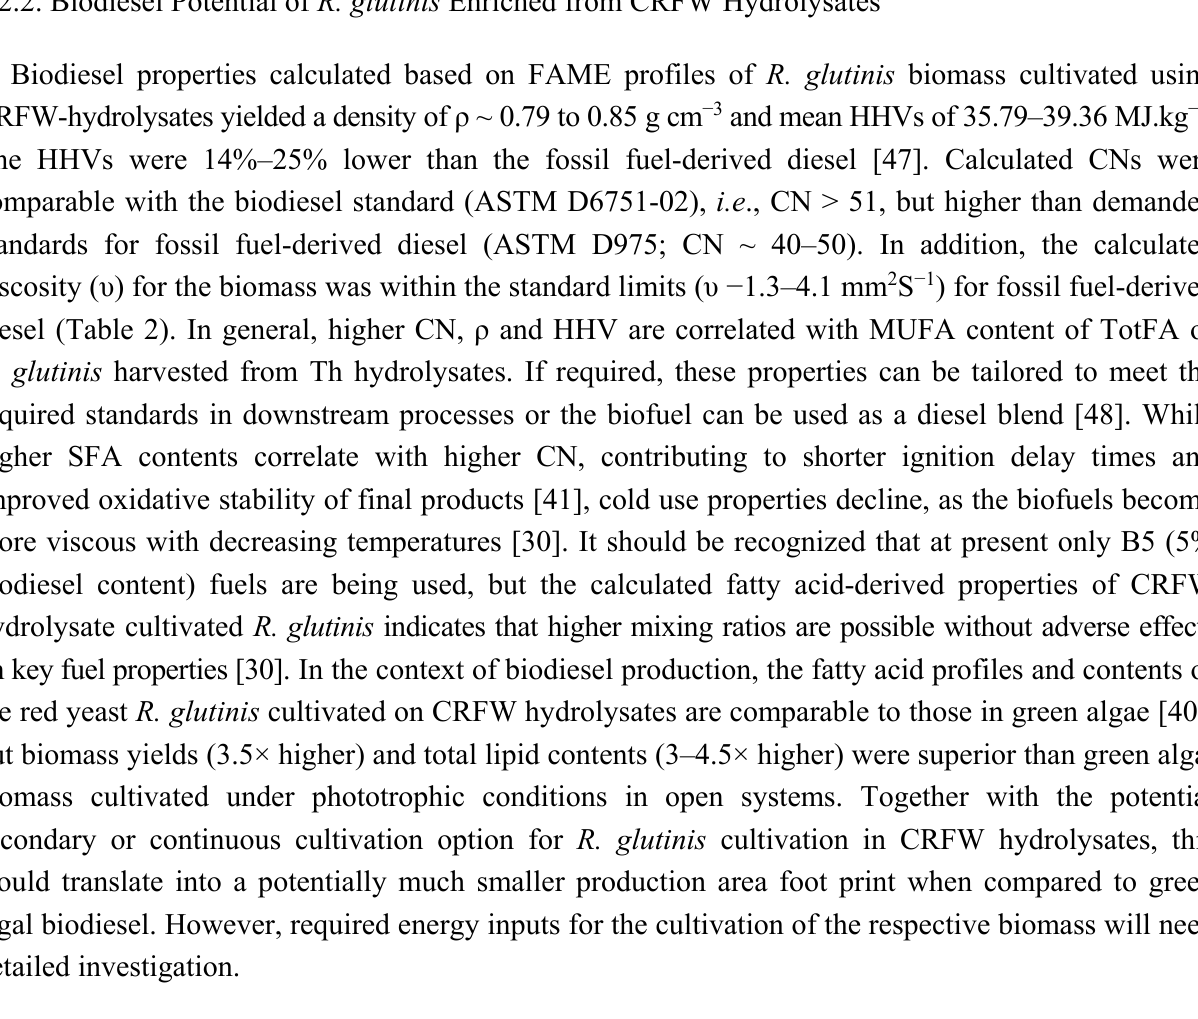
Table 2. Standard biodiesel properties as set by ASTM D6751-02 and EN 14214 and FAME-based calculated biodiesel properties of R. glutinis cultivated on CRFW